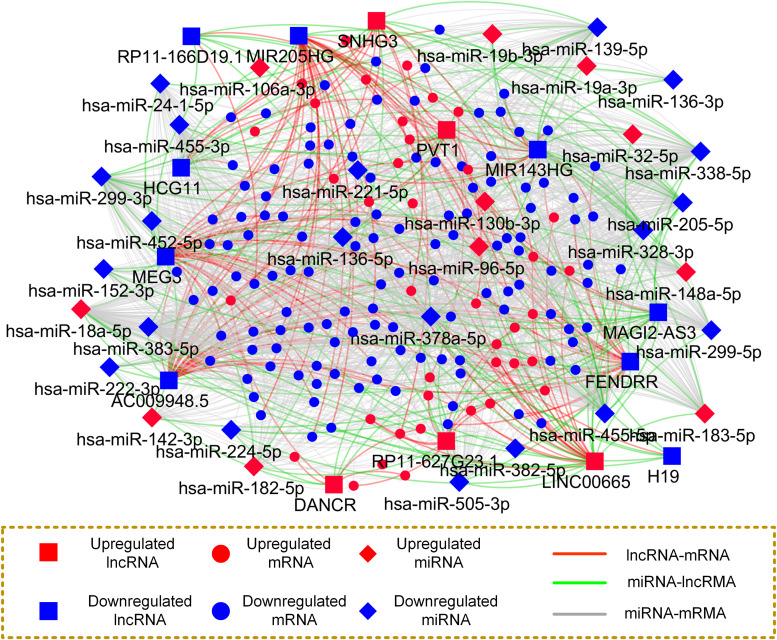
Construction of PCa tissue specific and high confidence ceRNA network. Nodes in this network represent different types of ceRNAs, and edges represent the interactions among these ceRNAs.